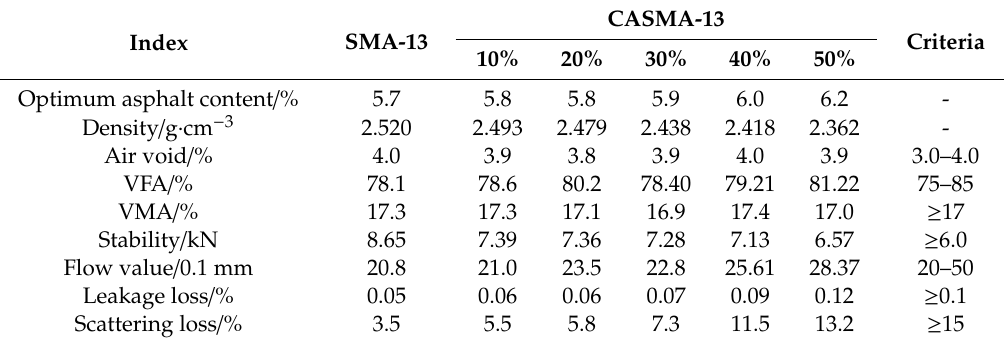
Table 3. Marshall test results of stone mastic asphalt containing CA.